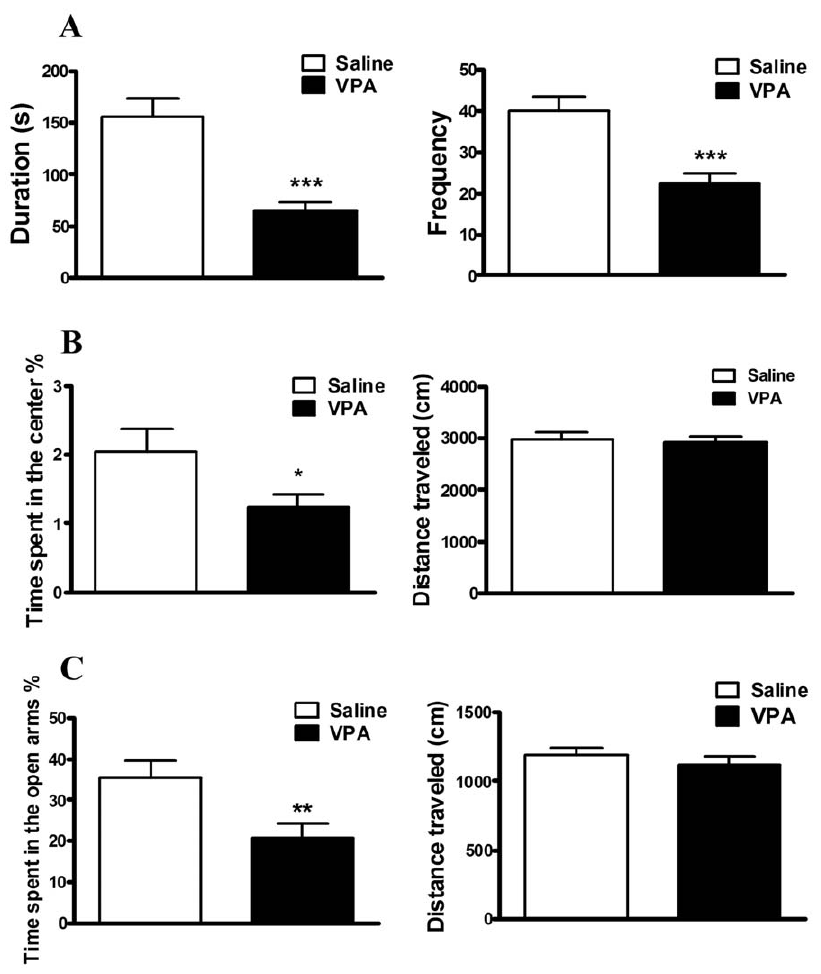
Figure 1. Social interaction and anxiety behavior in the male VPA offspring. Social impairment in (A) the social interaction test. The male VPA offspring exhibited a lower duration and frequency compared with the male saline offspring in the social interaction test. ***p , 0.001 (Saline, n=26; VPA, n=36). Increased anxiety in (B) the open field test. The male VPA offspring spent less time in the center percentage, but there was no significant difference in the distance traveled as compared with the male saline offspring. *p , 0.05 (Saline, n=28; VPA, n=37). (C) Elevated plus maze test. The male VPA offspring spent a lower percentage of time in the open arms, but there was no significant difference in the distance traveled as compared with the saline offspring. **p , 0.01 (Saline, n=27; VPA,